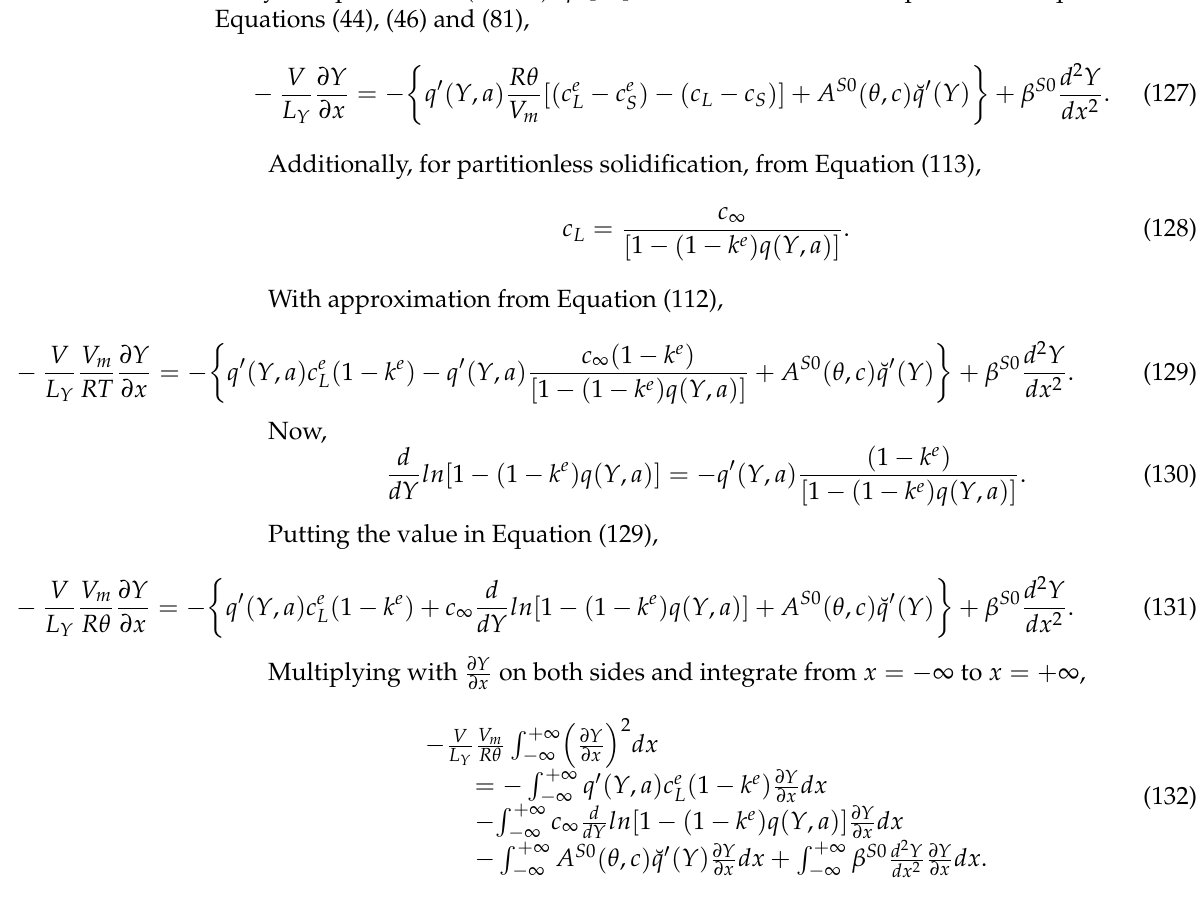
Figure 3. Variation of partition coefficient as a function of P .